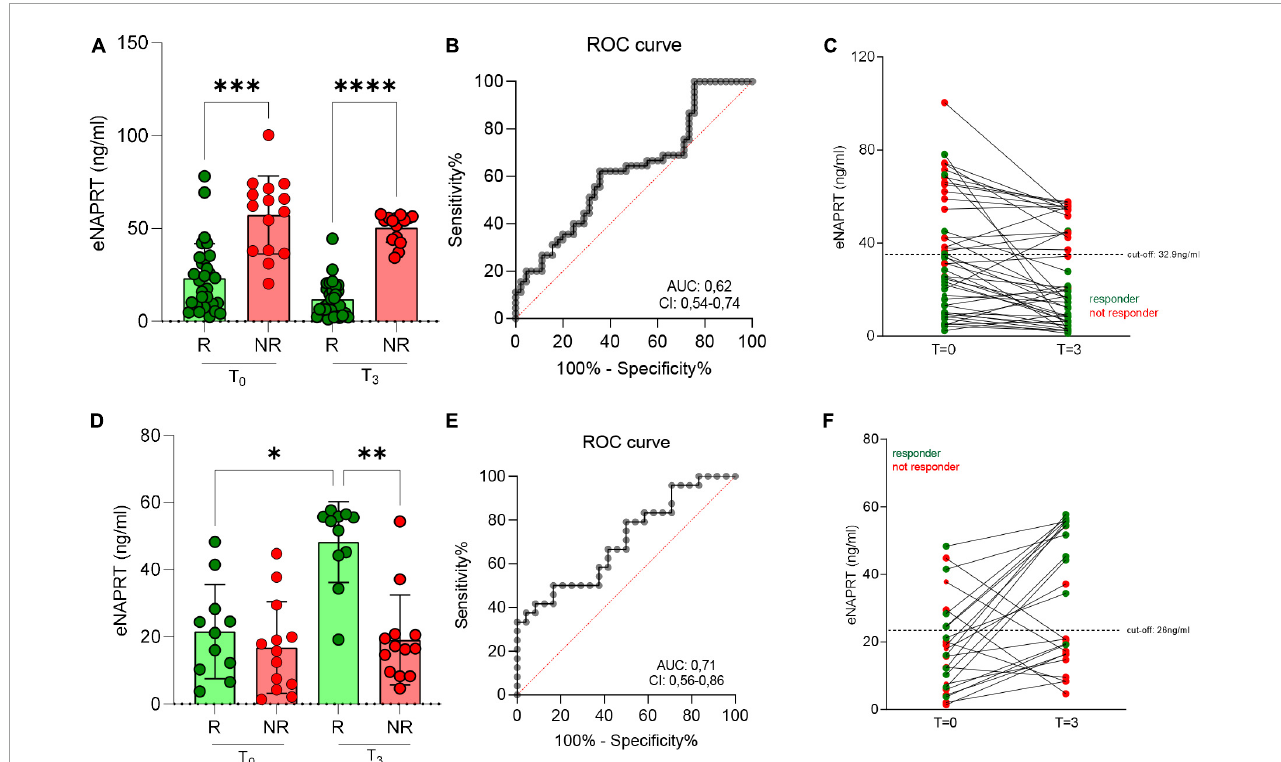
FIGURE4 Serum eNAPRT levels and response to anti-TNF treatment in IBD patients. (A) eNAPRT levels in responders (R) and non-responders (NR) to adalimumab at baseline ( T = 0) and after 3 months from the first infusion ( T = 3). N = 62: CD = 58, UC = 4. (B) ROC curve of adalimumab response. (C) eNAPRT levels in single patients after adalimumab infusion. Red dots represent NR, green dots represent R. N = 62: CD = 58, UC = 4. (D) eNAPRT levels in R and NR to vedolizumab at baseline ( T = 0) and after 3 months from the first infusion ( T = 3). N = 40: CD = 23, UC = 17. (E) ROC curve of vedolizumab response. (F) eNAPRT levels in single patients after vedolizumab infusion. N = 40: CD = 23, UC = 17. Red dots represent NR, green dots represent R. P -value: ∗ p < 0.05; ∗∗ p < 0.01; ∗∗∗ p < 0.001, and ∗∗∗∗ p <